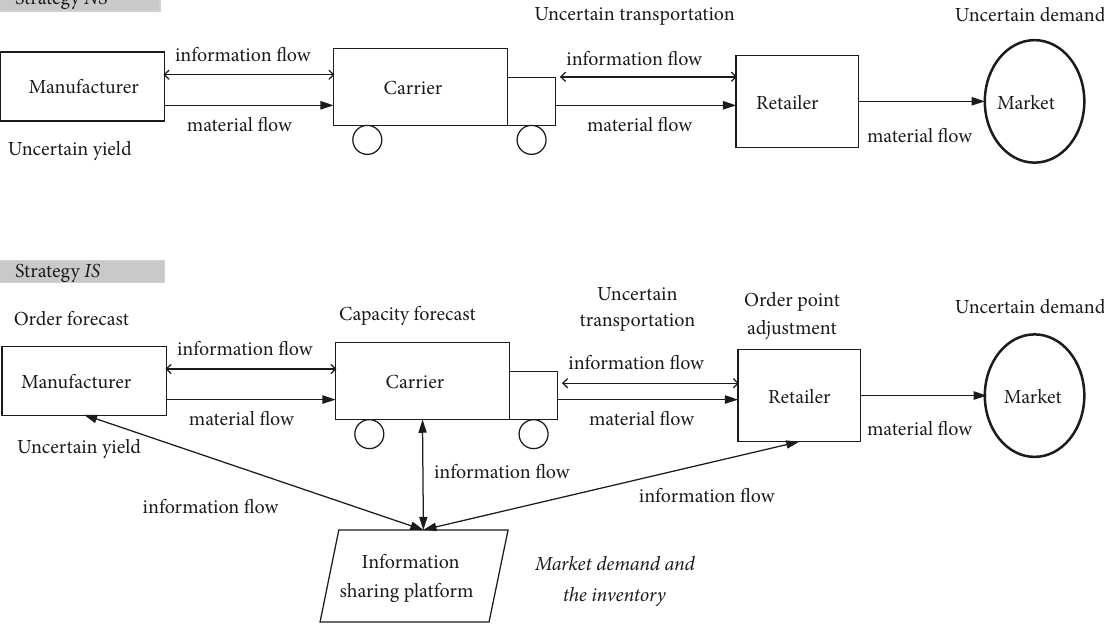
Figure 1: Two strategies: IS and